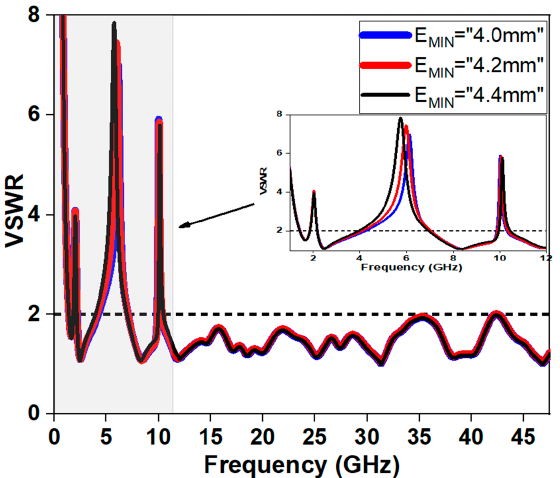
Figure 7. Parametric variation of independently controllable C band notch by varying E MIN. 3.3. Independently Controllable Notch X Band (9.8–10.4 GHz) For a split elliptical slot of major axis length EMAX, minor axis length EMIN, and width ER, the design equations for calculating a band-notch at a given frequency can be represented as Equation